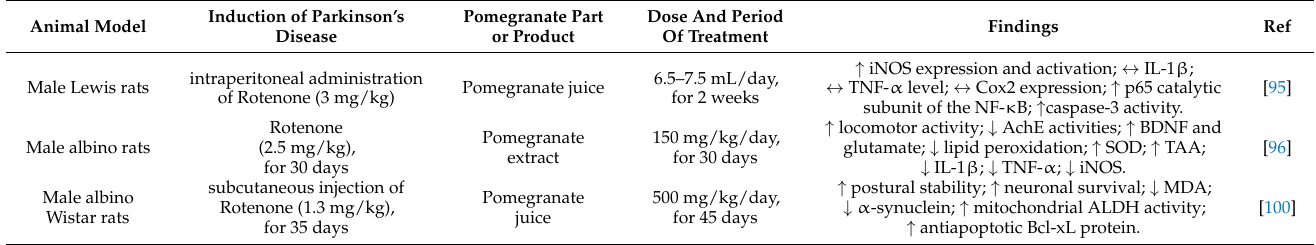
Table 4. Summary of the main findings related to Pomegranate supplementation effect on Parkinson’s disease